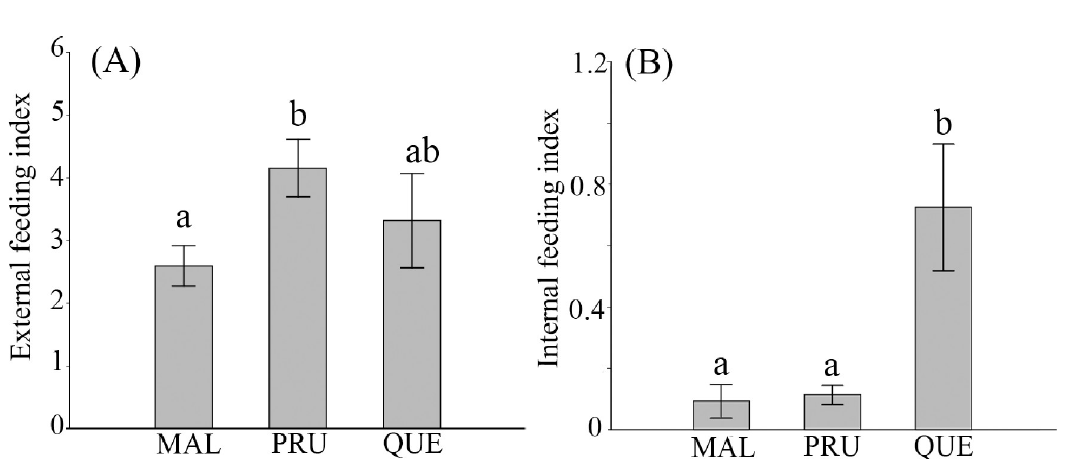
Fig 3. The chewing rate (A) and the sum of internal feeding (B)( ± standard error) of the three plant species across the 18 islands . Different alphabet above the bar indicates the significant difference at P < 0.05.